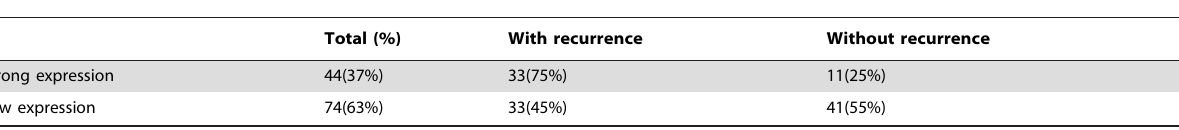
Table 3. Correlation TCF3 expression with recurrence in